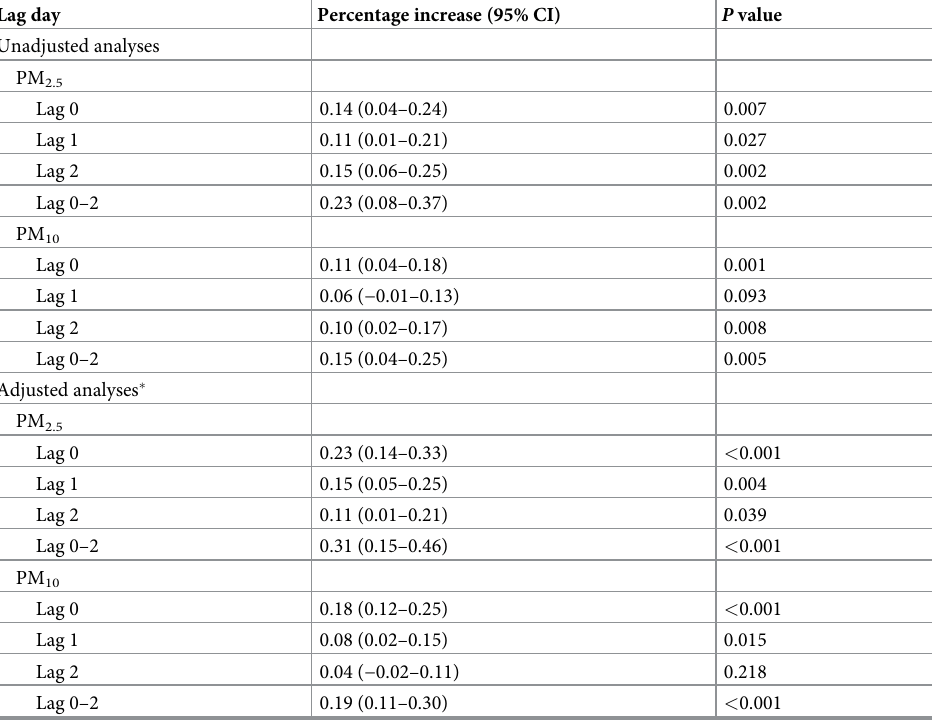
Table 3. National-average percentage increase with 95% CI in daily hospital admissions for pneumonia associated with a 10 μ g/m 3 increase in PM 2.5 and PM 10 concentrations using different lag days in 184 Chinese cities, 2014– 2017.